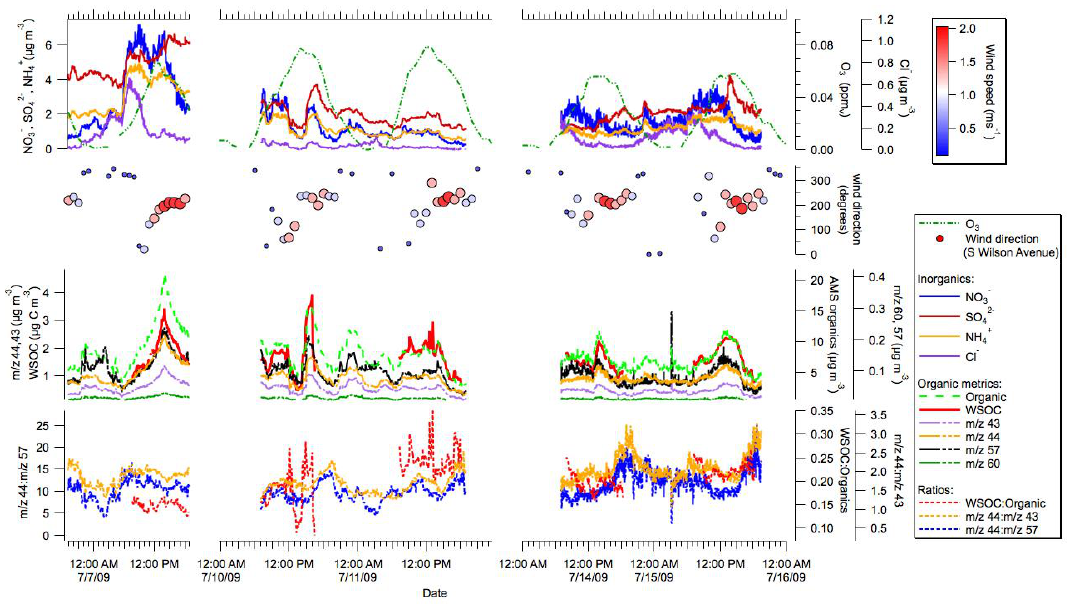
Figure 6 . Time series of various measured and derived parameters during selected days outside the fire period. The symbol size for wind direction is proportional to measured wind speed (South Wilson Avenue station).